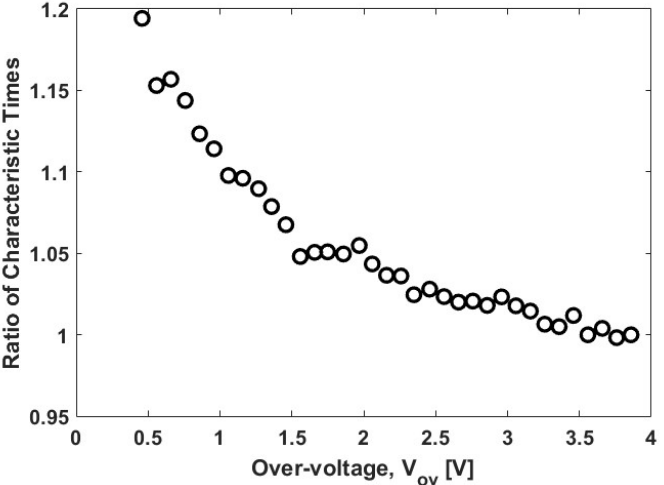
Figure 10. The ratio between the characteristic time obtained from the saturated current at each over-voltage to this time for an over-voltage of 3.85 V.